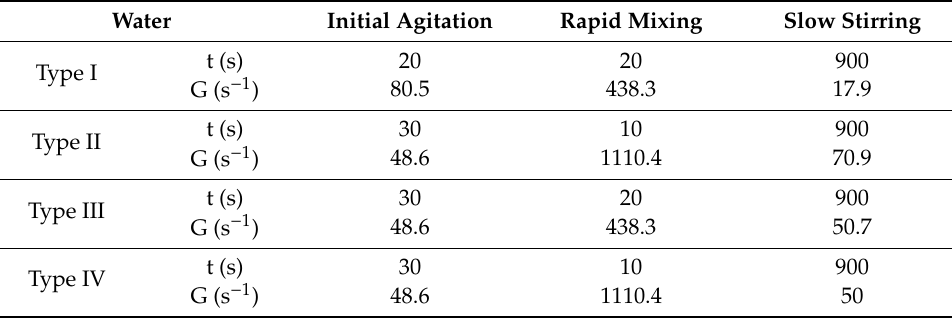
Figure 2. Jar Test trial schematic representation. Table 4. Jar Test agitation parameters: time (t) and velocity gradient (G).